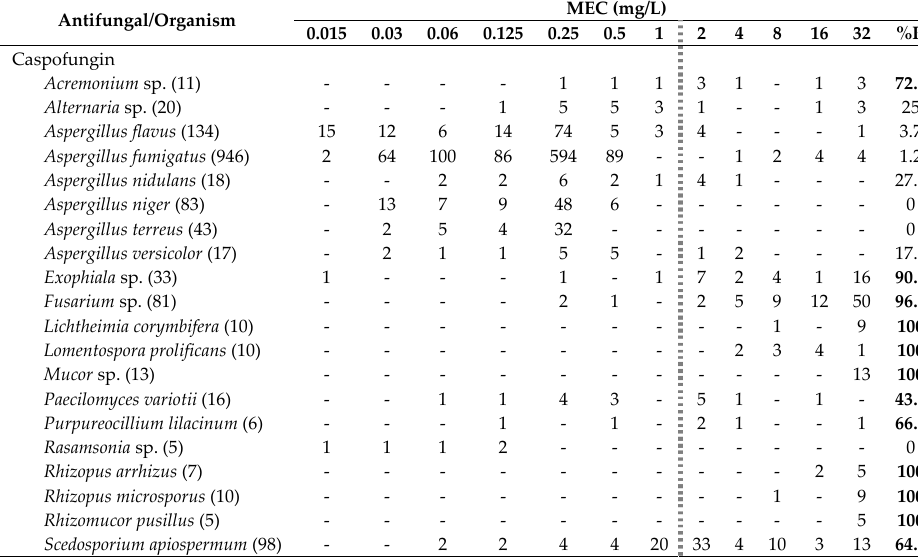
Table 5. Minimum effective concentration (MEC) distributions for caspofungin. For presentation conventions, see Legend to Table 1.